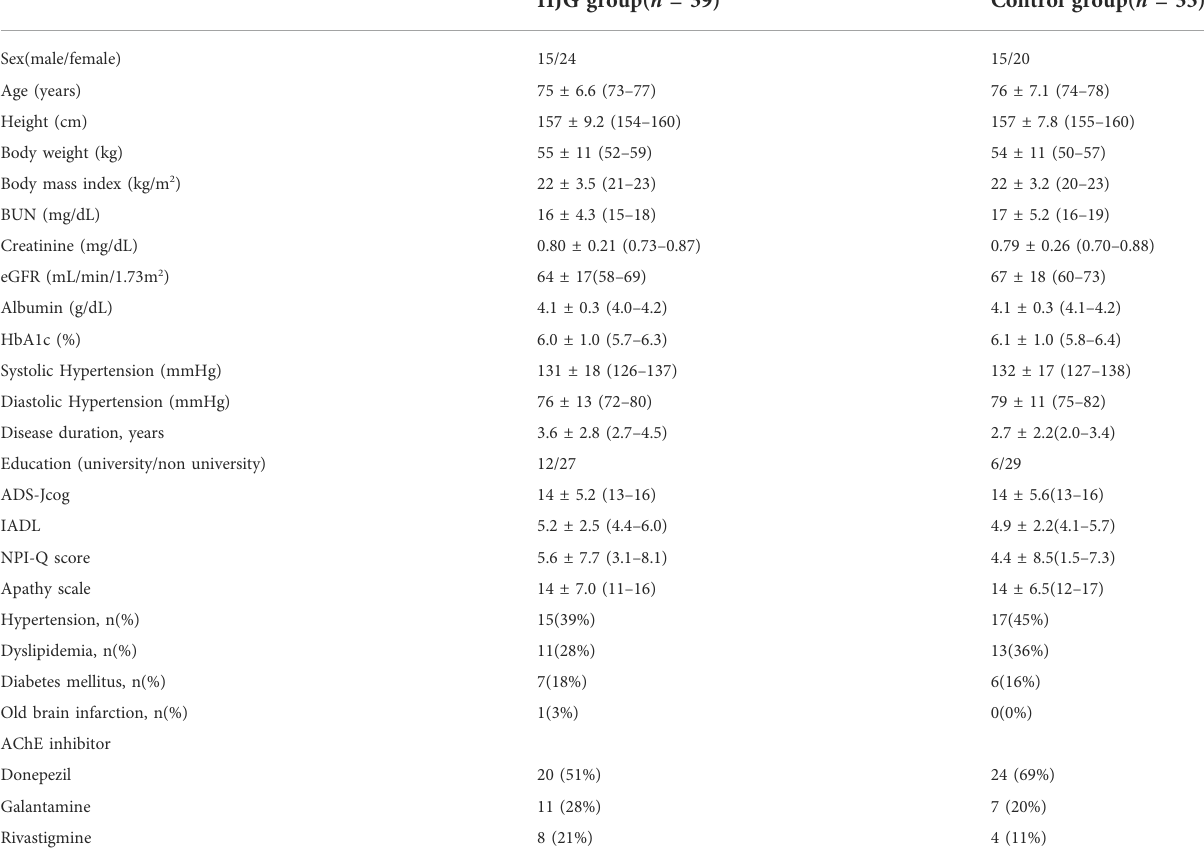
TABLE 1 Baseline